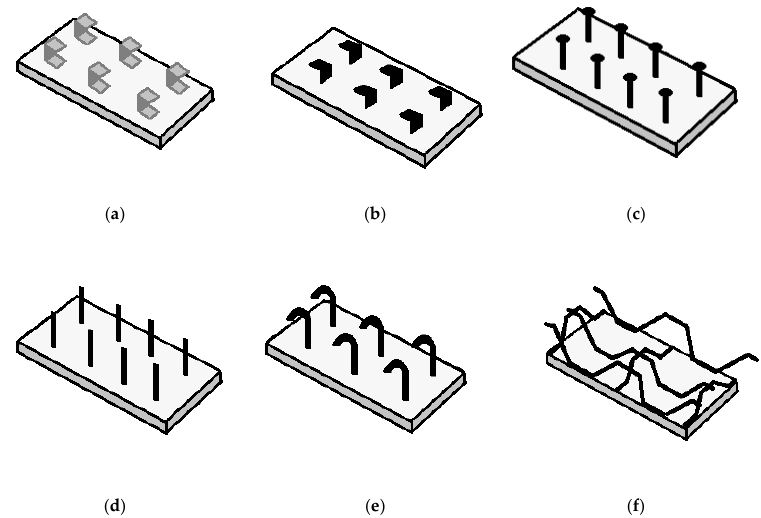
Figure 1. Shear connectors in SCS sandwich structures. ( a ) C-shaped connectors, ( b ) L-shaped connectors, ( c ) overlapped headed studs in DSC system, ( d ) friction welding connectors in Bi-steel structure, ( e ). J-hook connectors, ( f ). corrugated-strip connectors (CSC).